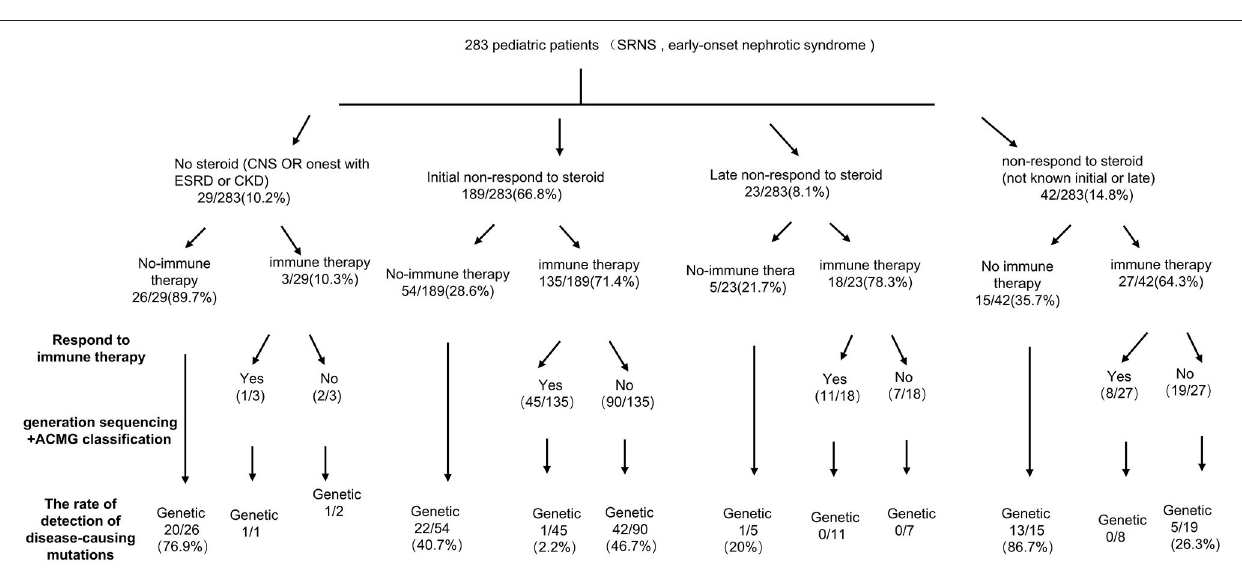
FIGURE 2 | A precision medicine-based guide to investigation of